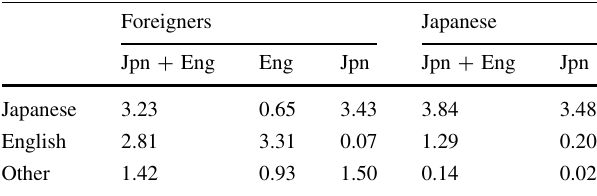
Fig. 3 Utilized media modes by media mode language. Chi square significance codes: *** p \ .001, ** p \ .01, * p \ .05 Table 6 Average number of utilized media modes by